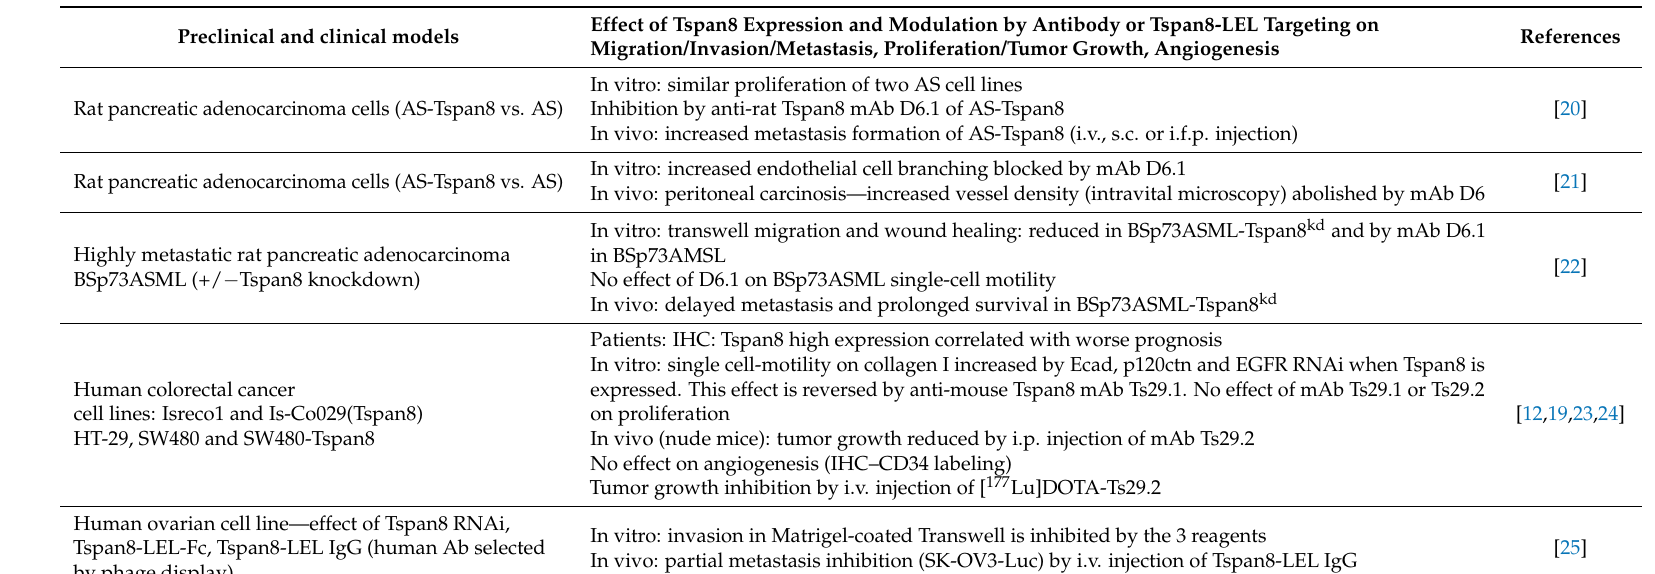
Table 1. Summary of studies dealing with biological consequences of Tspan8 targeting using specific